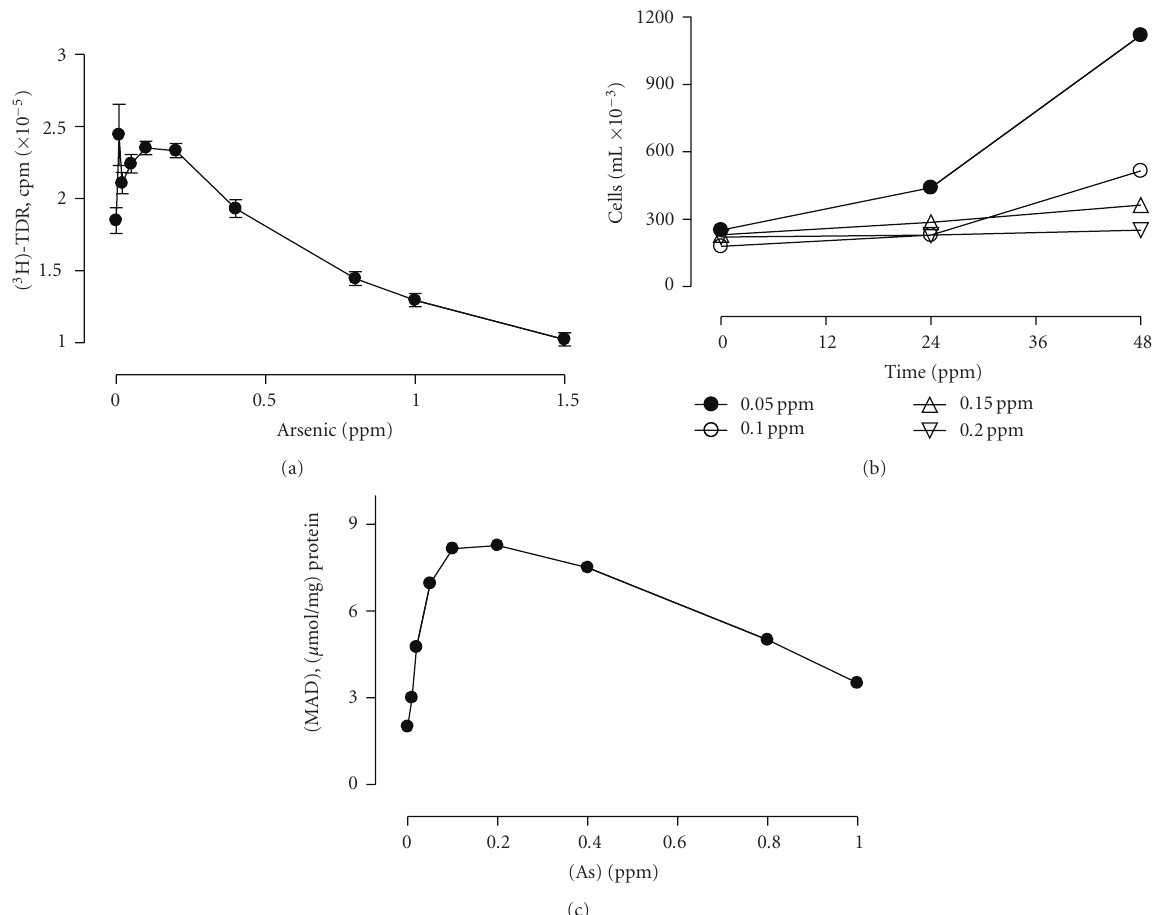
Figure 5: E ff ect of sodium arsenite on Jurkat cells. (a) Inhibition of proliferation of PHA-stimulated Jurkat cells by sodium arsenite. Cells (2 × 10 5 cells/well) were incubated as indicated before, and proliferation was assessed by [ 3 H]-TdR incorporation. Results are expressed in counts per minute (cpm) in the absence and presence of di ff erent sodium arsenite concentrations. (b) Evaluation of proliferation of cells (2 × 10 5 cells/well) stimulated with 5 μ g/ml PHA for 48h. Results are expressed as the number of cells obtained in the presence of di ff erent sodium arsenite concentrations in the culture media. (c) Lipid peroxidation in Jurkat cells induced by arsenic. Cells (2 × 10 5 cells/well) were incubated with sodium arsenite for 48h and the level of lipid peroxides was measured in the homogenates as MDA